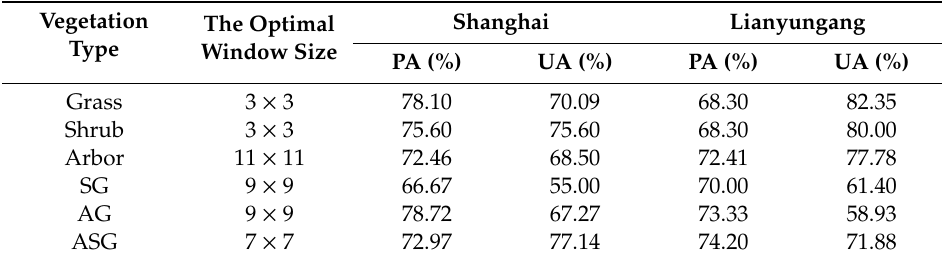
Table 12. The optimal CLBP window